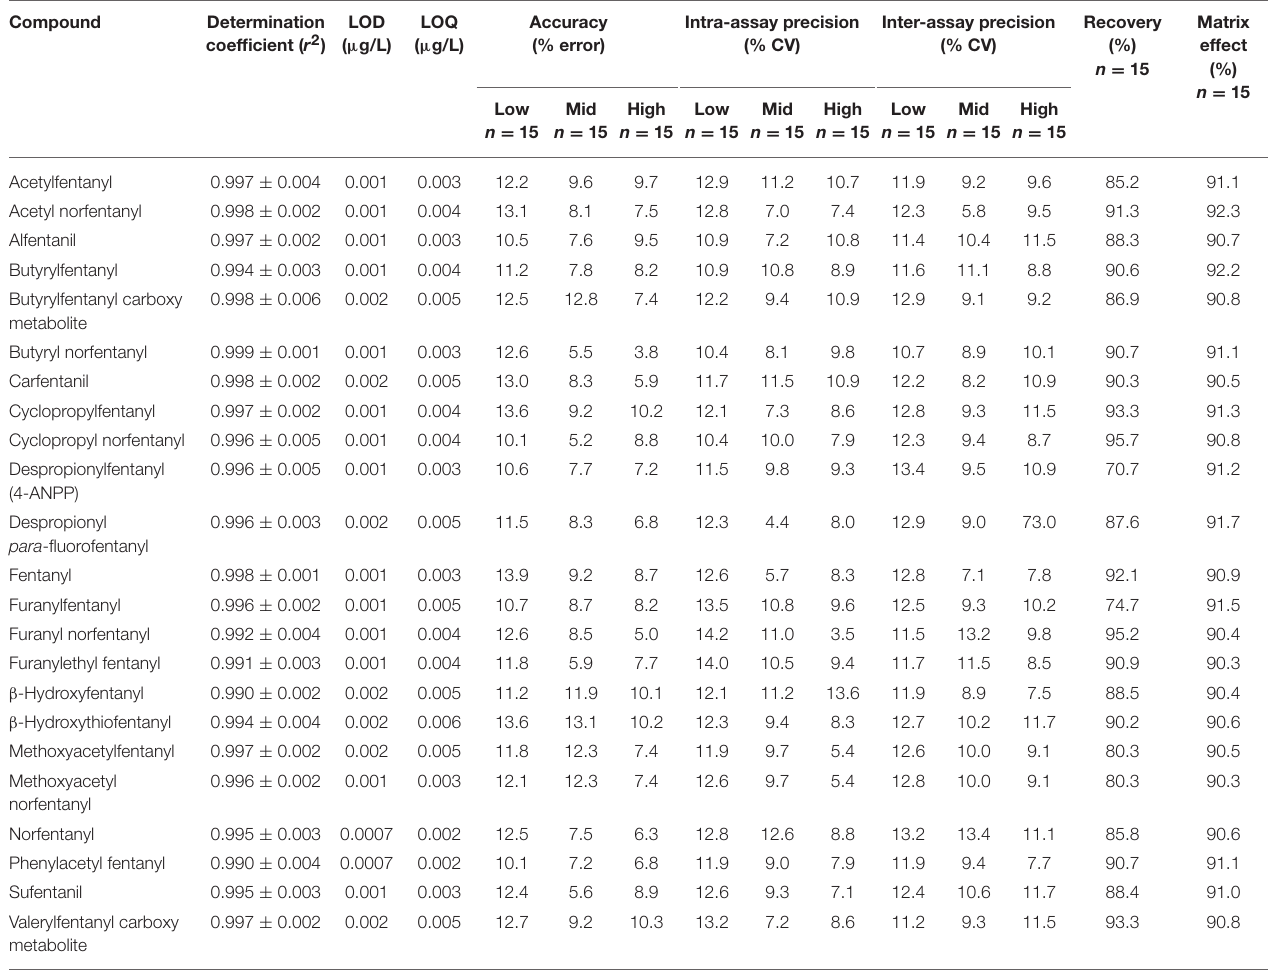
TABLE 2 | Validation parameters for fentanyl and analogs in whole blood.